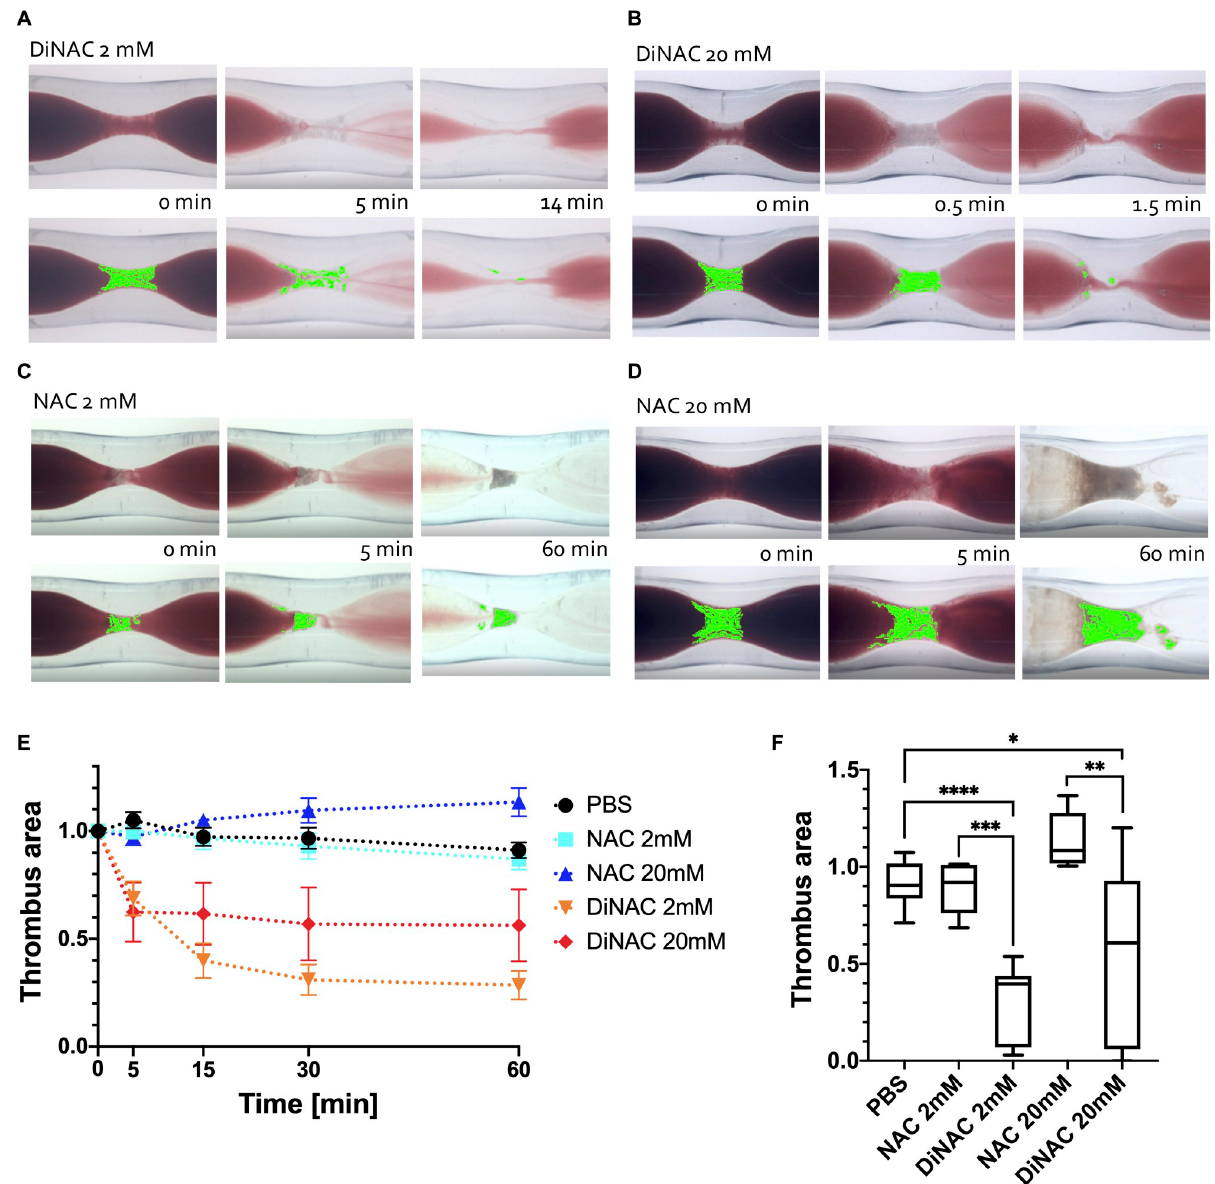
Fig 2. Perfusion with DiNAC and NAC. Thrombus surface area was determined by pixel counting and is shown in paired images below originals, with thrombus area highlighted in green. A 2 mM DiNAC perfusion showing complete ( > 95% surface area reduction) lysis in 14 min. B 20 mM DiNAC perfusion showing complete lysis in 1.5 min. C 2 mM NAC perfusion, with minimal lysis ( < 20% surface area reduction) after 60 min. D 20 mM NAC perfusion after 60 min, again with minimal lysis even at increased concentration. E Thrombus area reduction over time. Phosphate-buffered saline (PBS) is included as a negative control (black line). F Thrombus area after 60 min perfusion with the indicated agent (x-axis). 2 mM and 20 mM DiNAC cause significantly more lysis than the control, while neither concentration of NAC was more efficacious than PBS. DiNAC was also significantly different than NAC at each concentration. � p < 0.05; �� p < 0.01; ��� p < 0.001; ���� p <